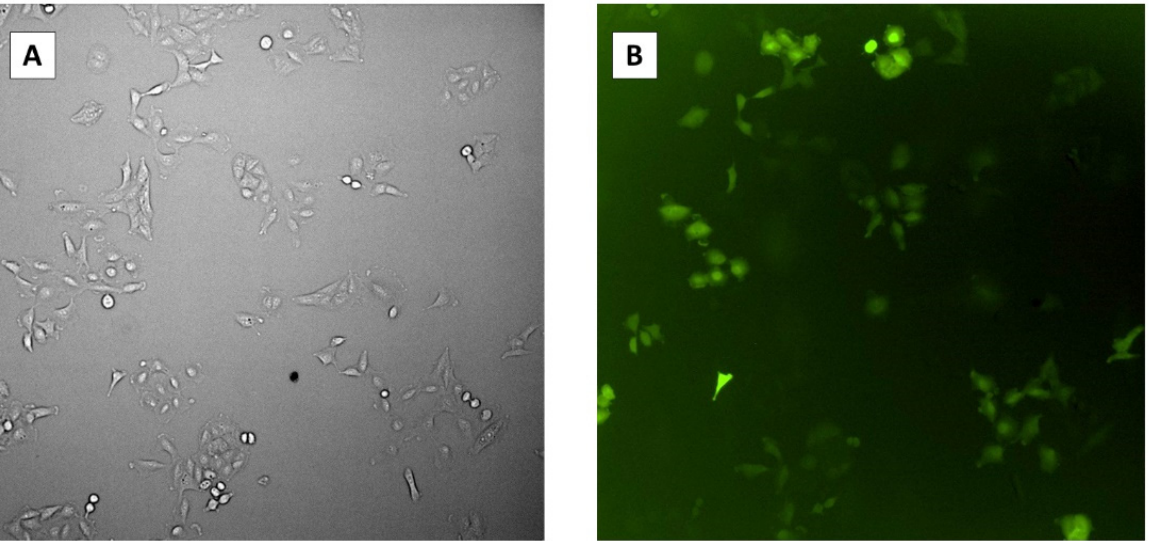
Figure 4. Microscopy images of transfection efficiency 48 h post-transfection. ( A ) Transfected Vero cells under bright field. ( B ) Transfected Vero cells under GFP fluorescence.